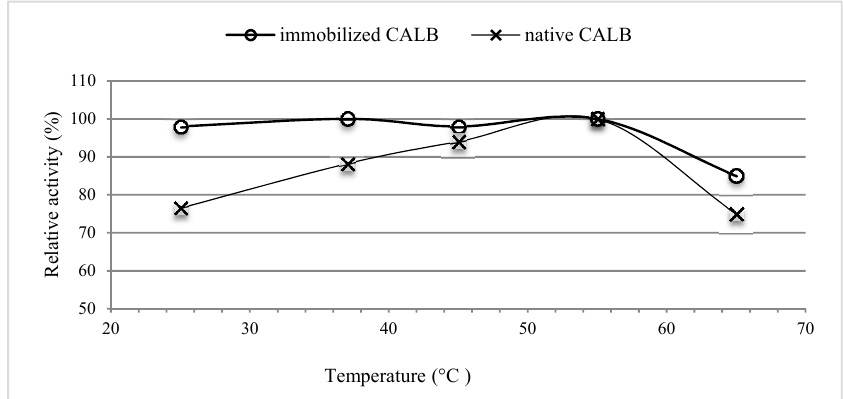
Figure 4. Effect of temperature on CALB activity. Reaction conditions: native lipase (1.26 mg) and immobilized CALB onto IB-D152 (50 mg of support), phosphate buffer (100 mM and pH 7.4), the emulsion of gum arabic and olive oil, the temperature in the range of 25–65 °C, and incubation 30 min.